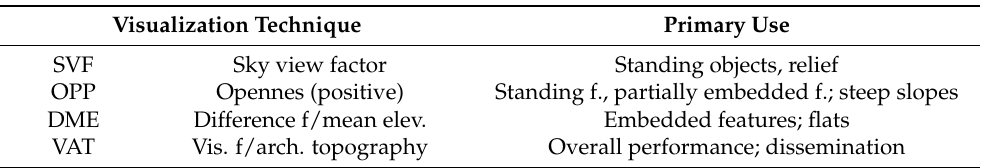
Table 4. DFM visualization techniques included in the pipeline and their primary use in interpretative mapping of archaeological features.